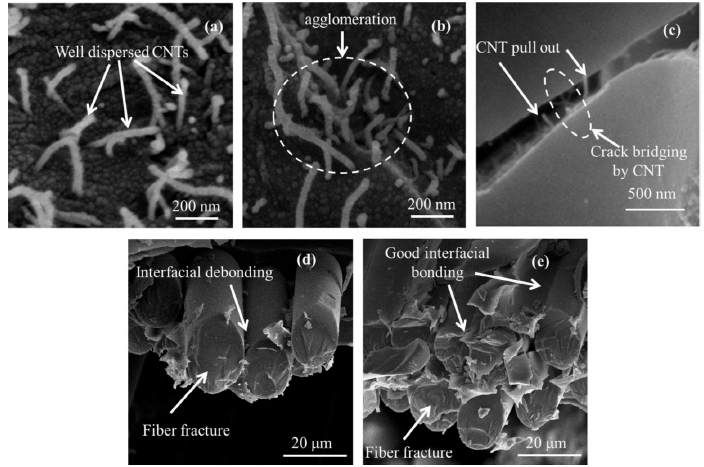
Figure 5. Dispersion of ( a ) 0.1%; ( b ) 0.5% multi walled carbon nanotubes (MWCNT) in glass/epoxy (GE) composite; ( c ) CNT pull out and crack bridging by CNT in 0.1% MWCNT–GE composite after room temperature test; glass fiber bundle ( d ) GE and ( e ) 0.1% MWCNT–GE composite [58]. Reprinted from Composites Part A, 84, Rathore D.K., Prusty R.K., Kumar D.S., Ray B.C., Mechanical performance of CNT-filled glass fiber/epoxy composite in in-situ elevated temperature environments emphasizing the role of CNT content, 364–376, Copyright (2016), with permission from Elsevier.